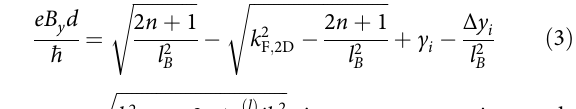
Fig. 4 Comparison of experiment and theory. a Landau Level wave functions for particular values of B z chosen to visualize the important stages of magnetic fi eld evolution. Note that the resulting vertical scale is highly nonlinear. The wave functions are obtained from a numerical Schrödinger solver, showing magnetic compression of the wave function and subsequent depopulation. The hard wall con fi nement completely separates wave function CM and GC position, the latter residing outside the physical sample for most of the B - fi eld range. Hybridization of LLs and UW 1 would result in an additional node for LL wave functions at the Fermi energy. In b